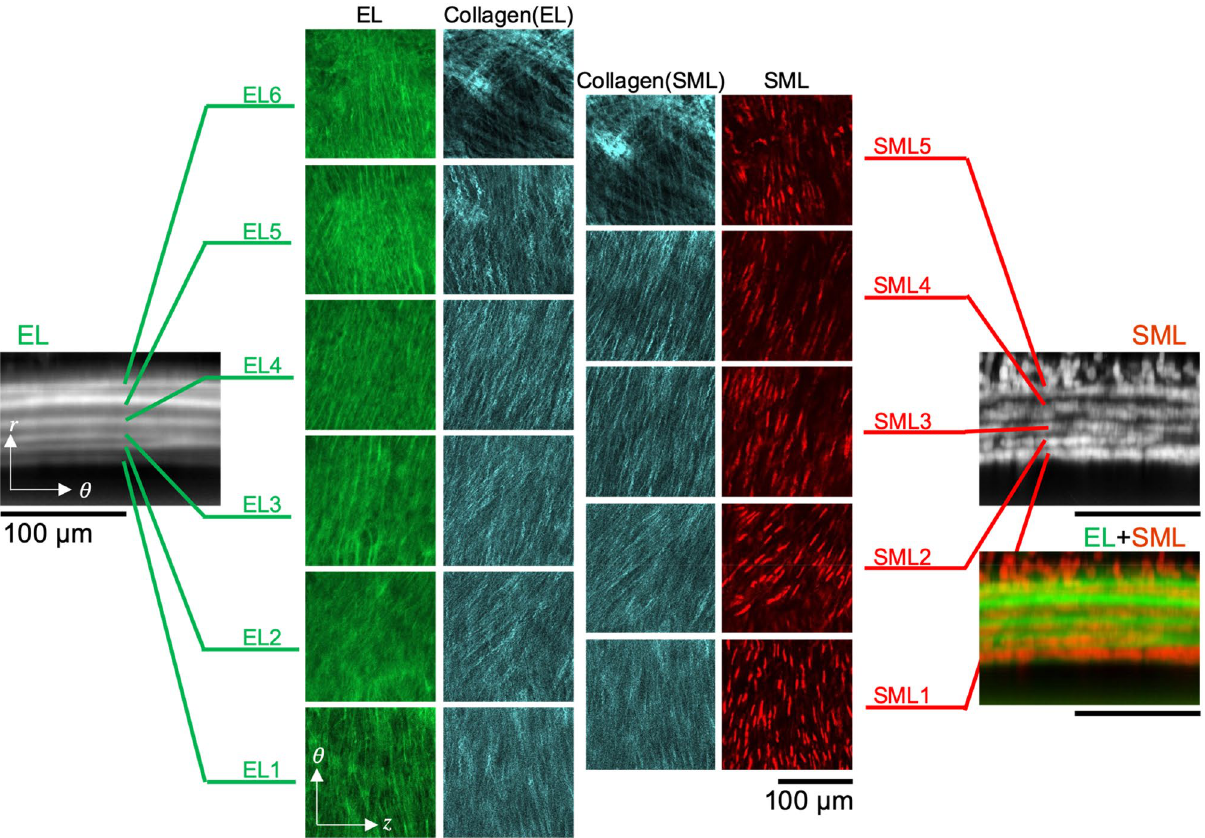
Figure 6. Layer-by-layer presentation of the microstructure of ELs, SMLs, and collagen fibers in both ELs and SMLs visualized in the cleared aorta. The axes of r , θ , and z indicate the radial, circumferential, and axial direction, respectively. Single slices from the depth-stack of EL, collagen, and SML on the θ − z plane are presented in the middle, exhibiting the microstructure of individual layers. The image of EL and SML on the r − θ plane (left and right, respectively) was created by projecting the image stack on θ − z plane to the r − θ plane (sum slices for EL and standard deviation for SML,